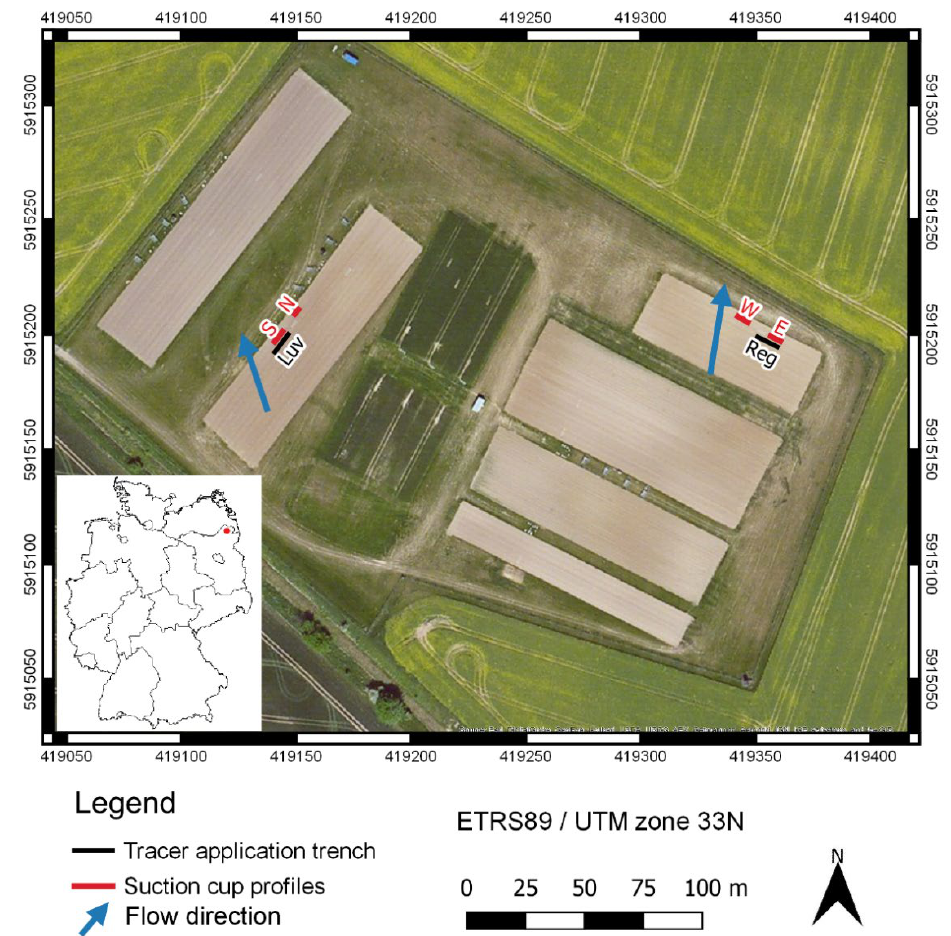
Figure 1. Map of the study site with the two tracer application sites at the Luvisol (Luv) and the Regosol (Reg). Suction cup profiles are located in the north (N), south (S), west (W), or east (E) of the respective plots. Assumed subsurface flow directions are indicated by arrows.